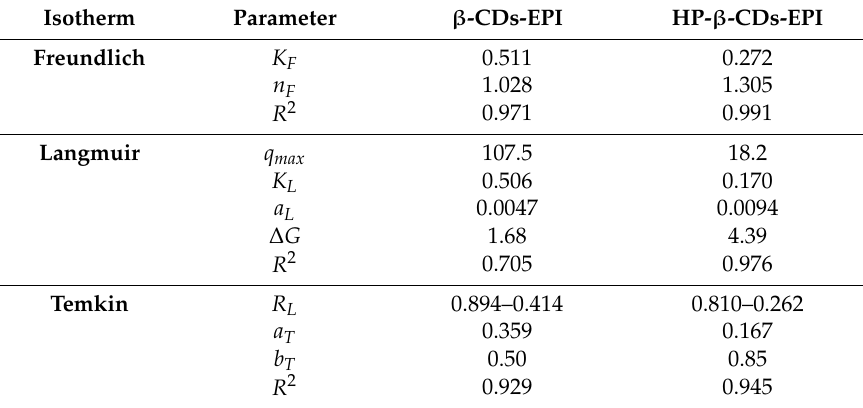
Figure 4. Adsorption isotherms for Direct Red 83:1 by β -CDs-EPI ( ● ) and HP- β -CDs-EPI ( ○ ). ( A ) Freundlich isotherm, ( B ) Langmuir isotherm, ( C ) Temkin isotherm, ( D ) Separation factor. Table 3. Adsorption isotherm constants obtained for β - and HP- β -CDs EPI polymers.